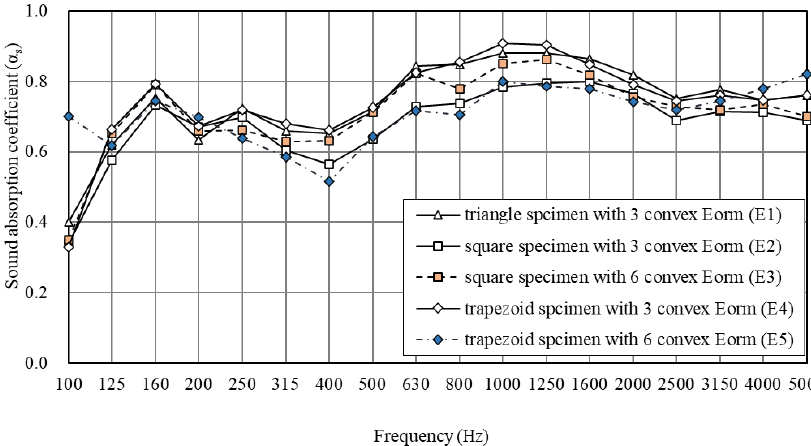
Figure 9. The sound-absorption coefficient of 80 mm FEMM with a 450 mm cavity.